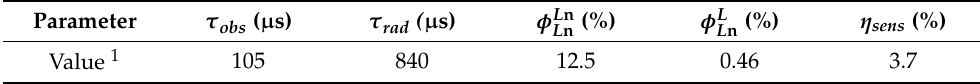
Table 2. The luminescent properties of [Yb(DPPDA) 2 ](DIPEA) in CD 3 OD solution at room temperature. Parameter